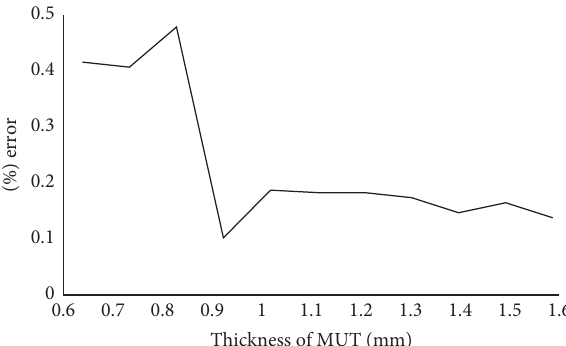
Figure 10: The percentage error in resonance shift versus thickness of